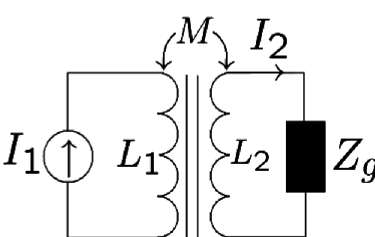
FIG. 2. Equivalent circuit for the Nassibian and Sacherer transformer picture, indicating the mutual inductance, M , be- tween twin-wire line and the kicker winding. L the self-inductance of the twin-wire line (representing the beam) and the kicker winding,